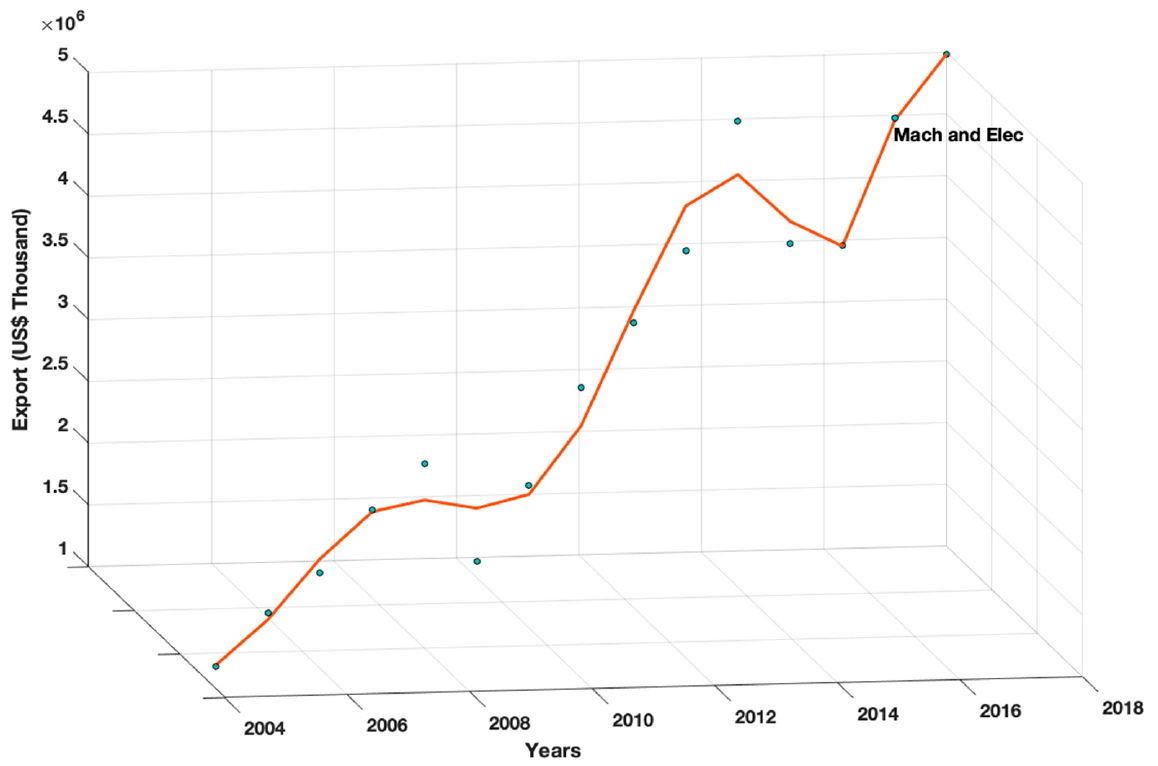
Figure 4. The degree 9 polynomial.